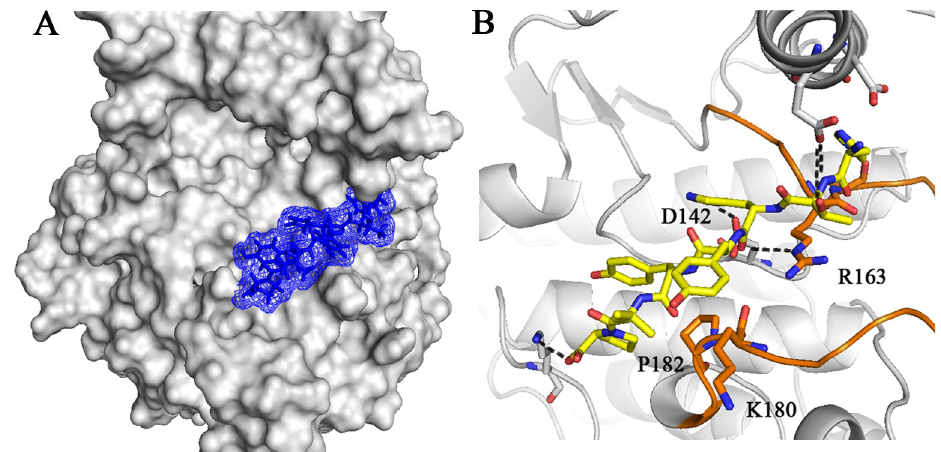
Fig 6. 3D representation of peptide 10 in interaction with EGFRL858R. Overview (A) and detailed view (B) of interactions of peptide 10 with the peptide-substrate binding site of EGFRL858R. (B) peptide 10 formed five hydrogen bonds with 4 key residues of EGFR kinase domain, Asp 142, Arg 163, Lys 180 and Pro 182 and occupied the phosphoacceptor site by a hydrogen bond between His 3 and Asp 142. Peptide 10 is shown in stick model. Black dotted lines indicate hydrogen bonds. The key residues of peptide-substrate binding site are illustrated in stick model.